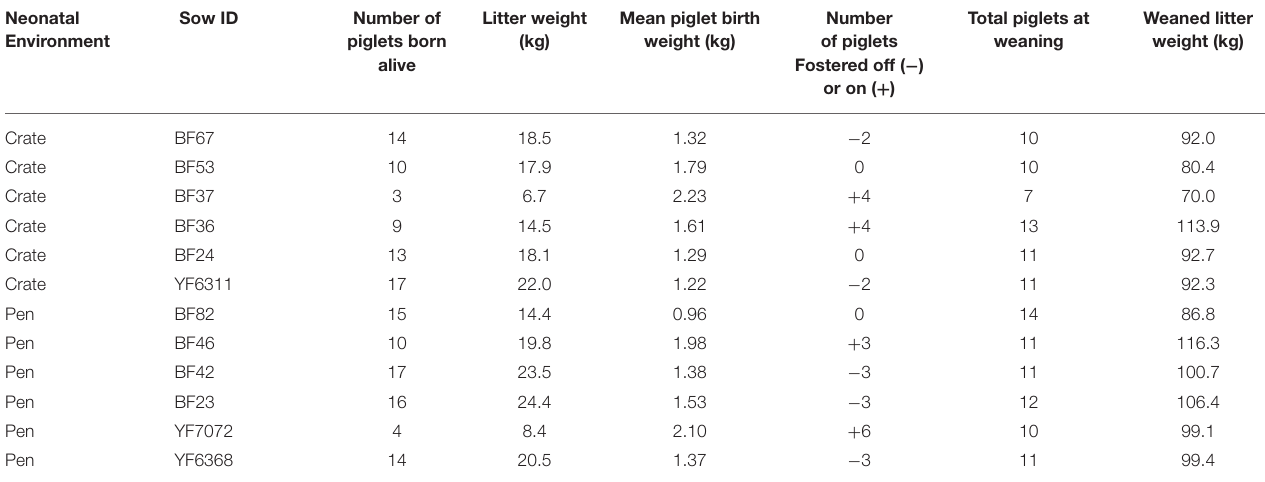
Sow ID Number of